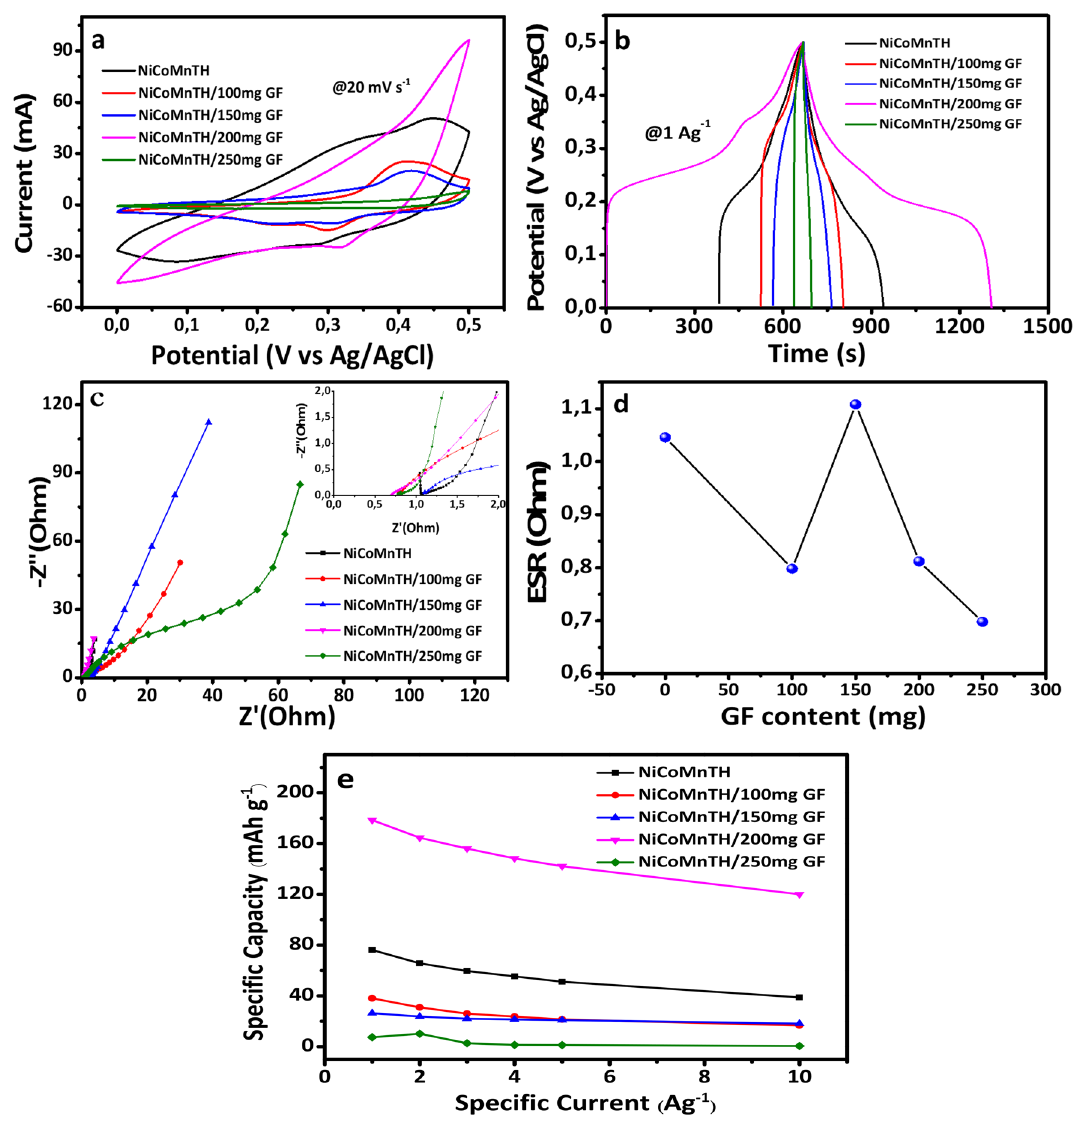
Fig. 8 a CV patterns at 20 mV s −1 , b GCD patterns at 1 A g −1 , c EIS Nyquist plot, with the inset showing low-frequency region, d equivalent series resistance versus graphene foam mass loading, and e specific capacity versus specific current of different